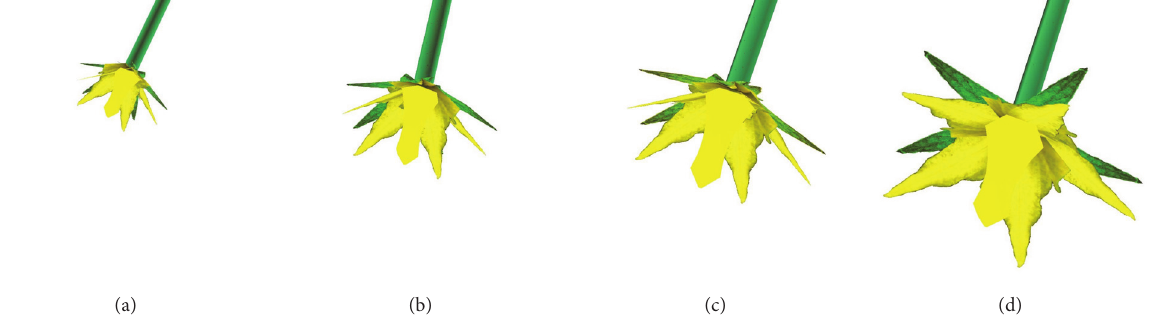
Figure 4: Modeling a flower